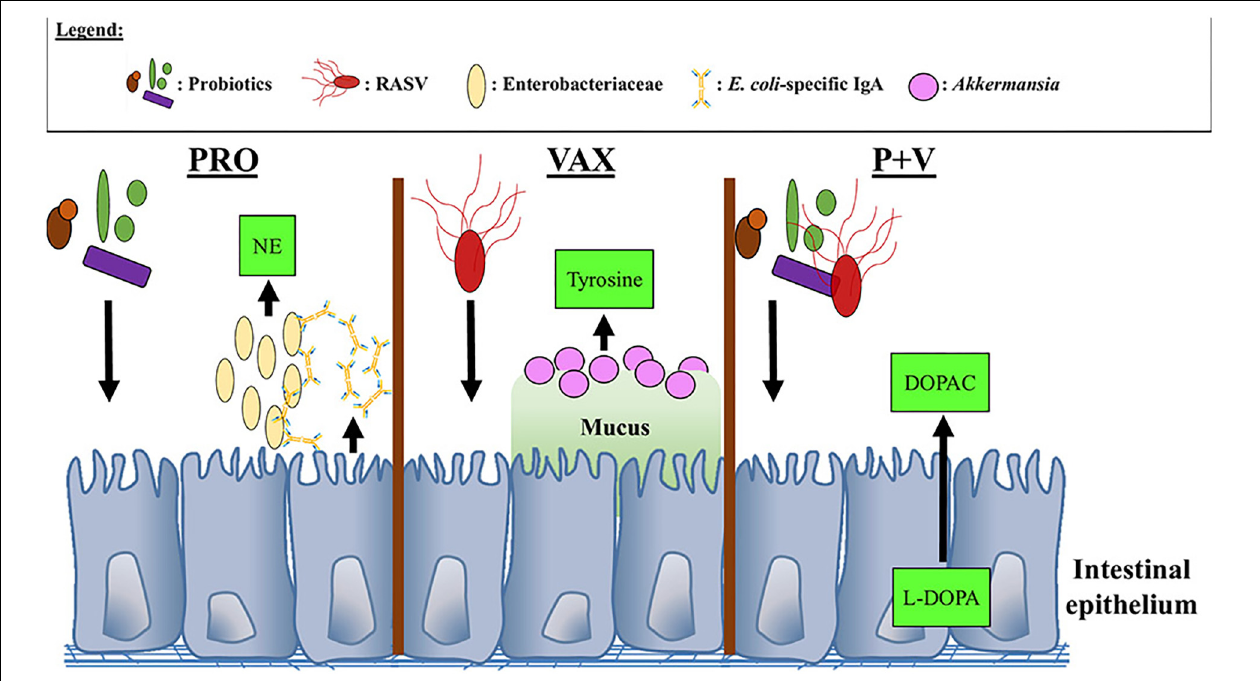
FIGURE 9 | Proposed interactions between neurochemical metabolites, bacteria, and IgA in the chicken ceca. NE, Norepinephrine; DOPAC, 3,4-dihydroxyphenylacetic acid; L-DOPA, L-3,4-dihydroxyphenylalanine.